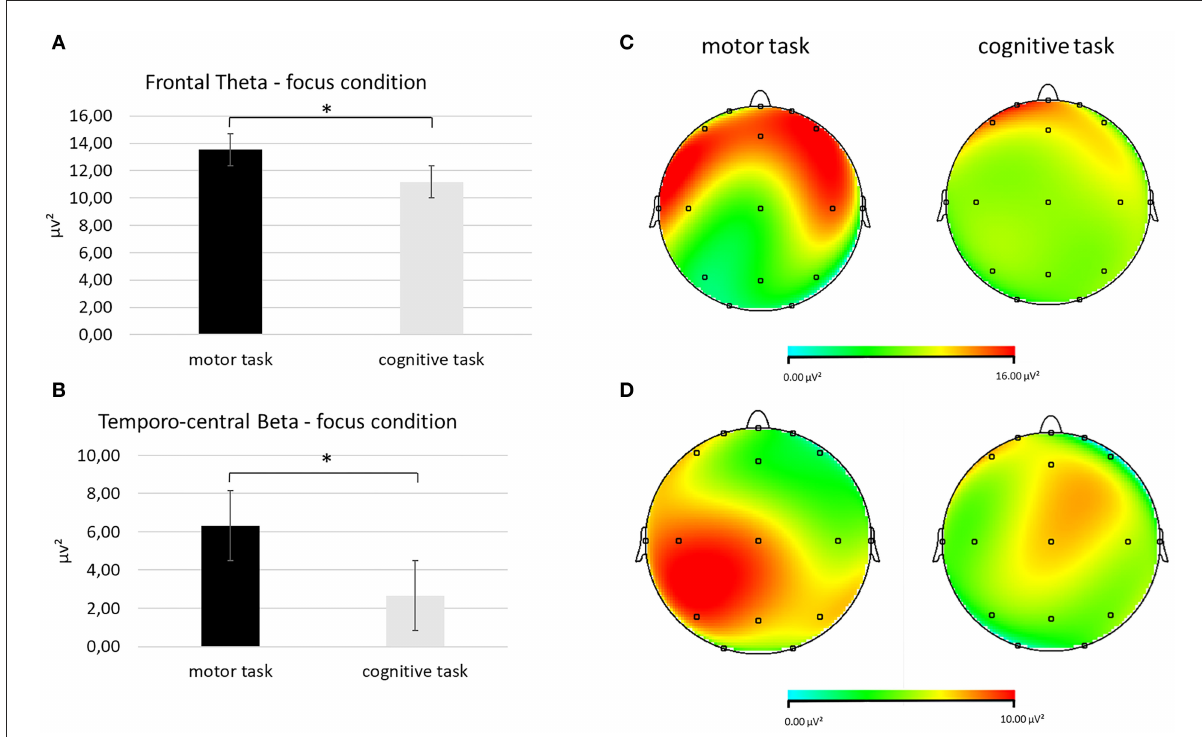
FIGURE4 EEG theta and beta band findings. (A) Bar chart showing frontal theta mean values in the focus condition during the two synchronization tasks. (B) Topographical mapping representing the theta power enhancement in the frontal regions (red area) in the focus condition during the motor compared with the cognitive synchronization task. (C) Bar graph displaying the significant increase in temporo-central beta values in the focus condition when performing the two synchronization tasks. (D) Red area represents higher beta power in the focus condition during the motor (left head) than the cognitive task (left head). For all charts, bars indicate ± 1 standard error (SE); all asterisks mark statistically significant differences, with p ≤ 0.05.